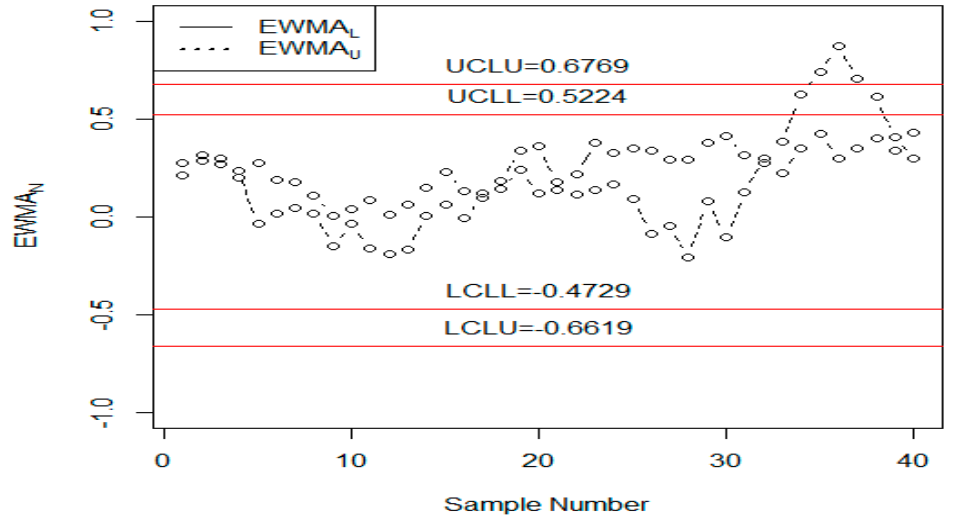
Figure 2. The control chart proposed by Reference [38] for simulated data.